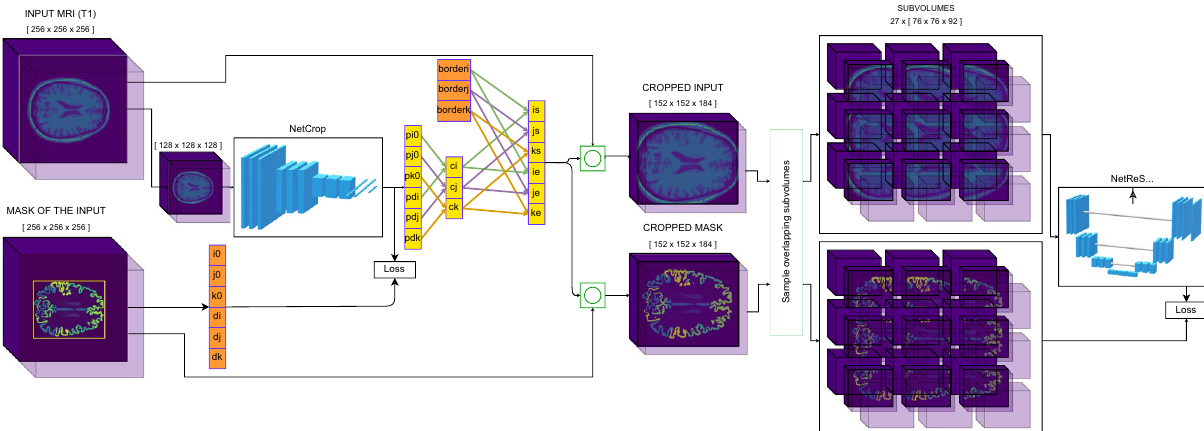
Figure 1. Schematic illustration of the ReSeg image processing pipeline consisting of two convolutional neural networks responsible for defining a bounding box around the input MRI volume (Net Crop ) and performing subsequent whole-brain segmentation on the cropped volume (Net ReSeg ). Net Crop is trained to predict the coordinates of a specific vertex point (pi 0 , pj 0 , pk 0 ) and the lengths of the edges along the i, j, and k axes (pd i , pd j , and pd k , respectively) of the bounding box circumscribing the brain in the input MRI volume. The target output vector [i 0 , j 0 , k 0 , d i , d j , d k ] for each image is computed from the FreeSurfer mask. The coordinates of the final bounding box were determined using the center point (c i , c j , c k ) of the bounding box predicted by Net Crop and fixed lengths (border i , border j , border k ) that had been defined based on the morphometric characteristics of adult human brains. The starting and end points of this bounding box along the i, j, and k axes are denoted by i s , j s , k s and i e , j e , k e , respectively. This bounding box was applied to the input MRI volume and, during training, to the corresponding FreeSurfer mask (denoted by green circles). Cropped input volumes and masks were used to train the segmentation network Net ReSeg. During inference, only MRI volumes are cropped and segmented. The figure was created with diagrams.net. JGraph Ltd: diagrams.net (Version 15.2.9)